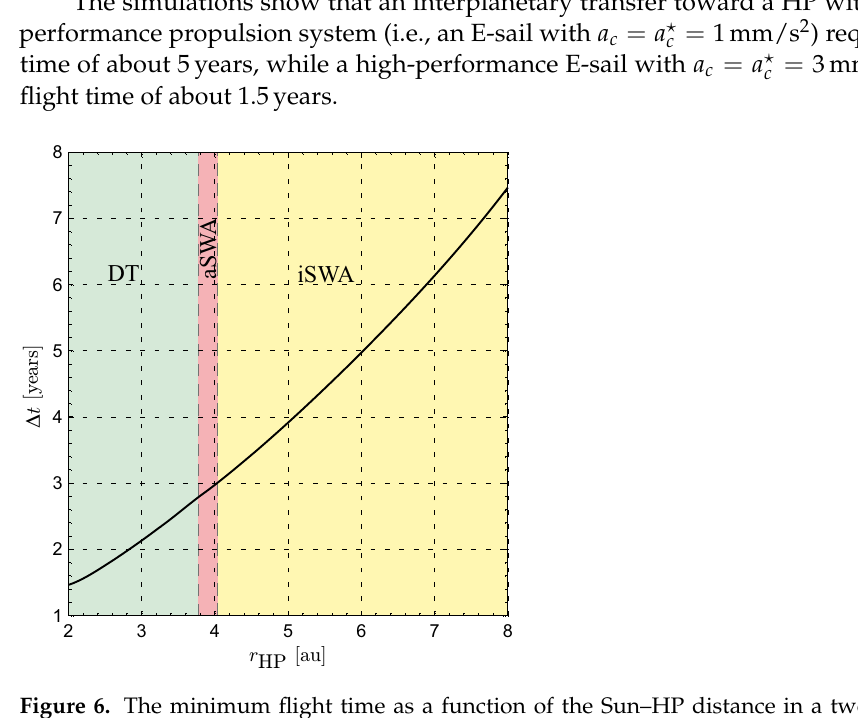
Figure 6. The minimum flight time as a function of the Sun–HP distance in a two-dimensional mission